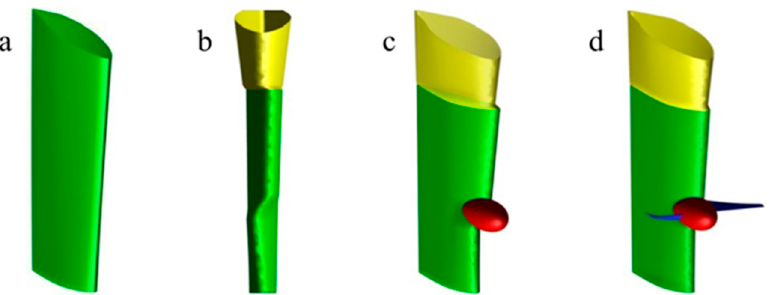
Figure 10. Types of rudders with energy saving design reproduced from [111] (CC BY-NC-ND). (( a ) Conventional rudder, ( b ) twisted rudder, ( c ) twisted rudder with bulb, ( d ) twisted rudder with bulb and fins).